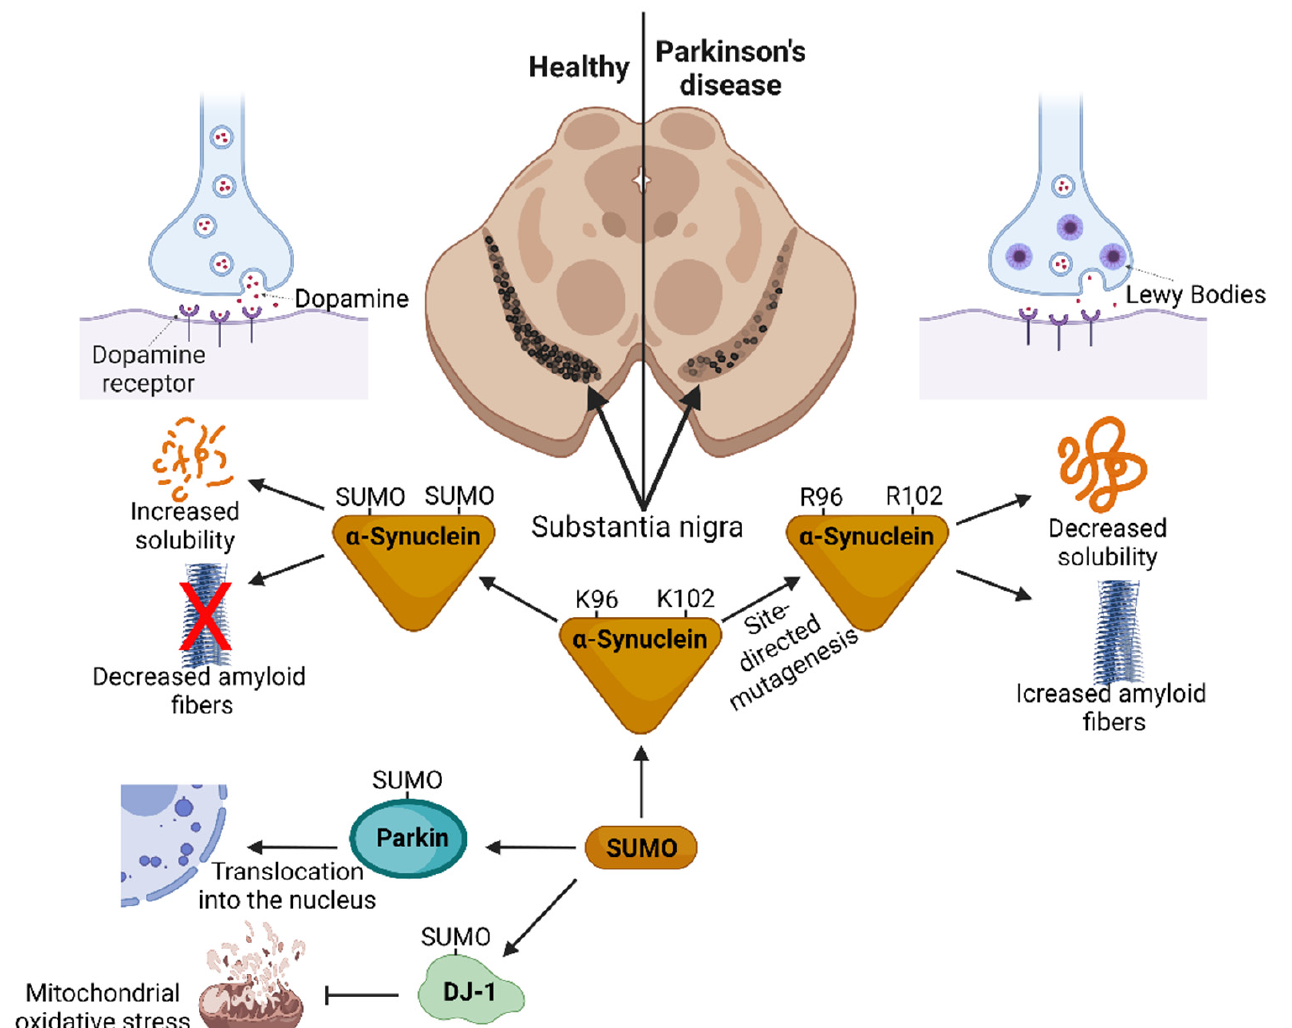
Figure 3. SUMOylation in Parkinson’s disease: SUMO-modified α -synuclein remains soluble and less amyloid fibers are formed. SUMOylation of DJ-1 promotes its activity and results in reduced mitochondrial stress. The SUMOylation of parkin promotes its nuclear transport. Figure was created with BioRender.com.